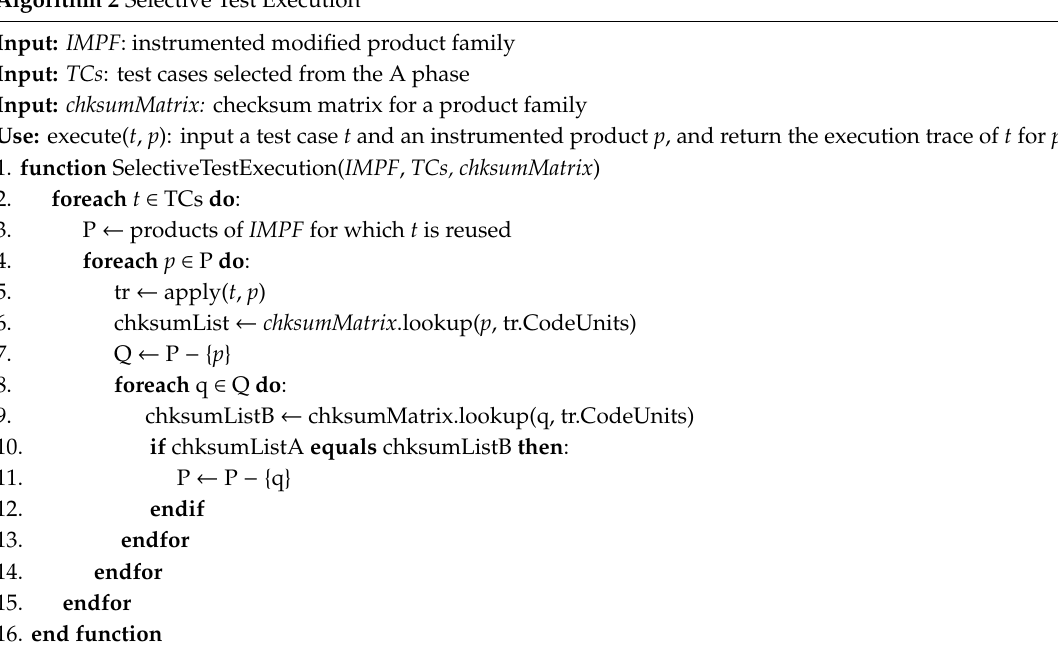
Algorithm 2 Selective Test